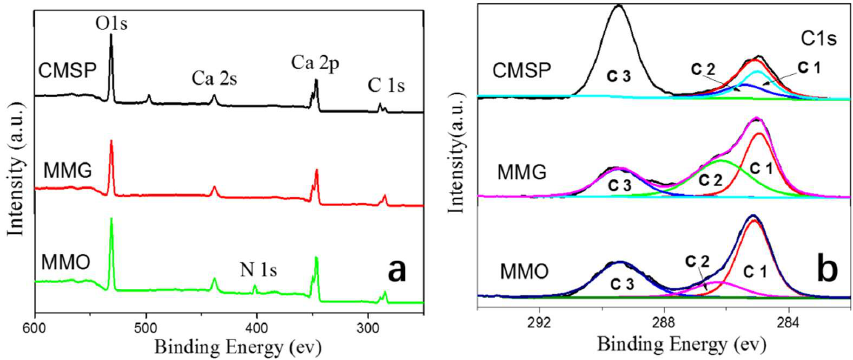
Figure 6. XPS spectra of CMSP, MMG, and MMO ( a ); and XPS survey scans ( b ) .